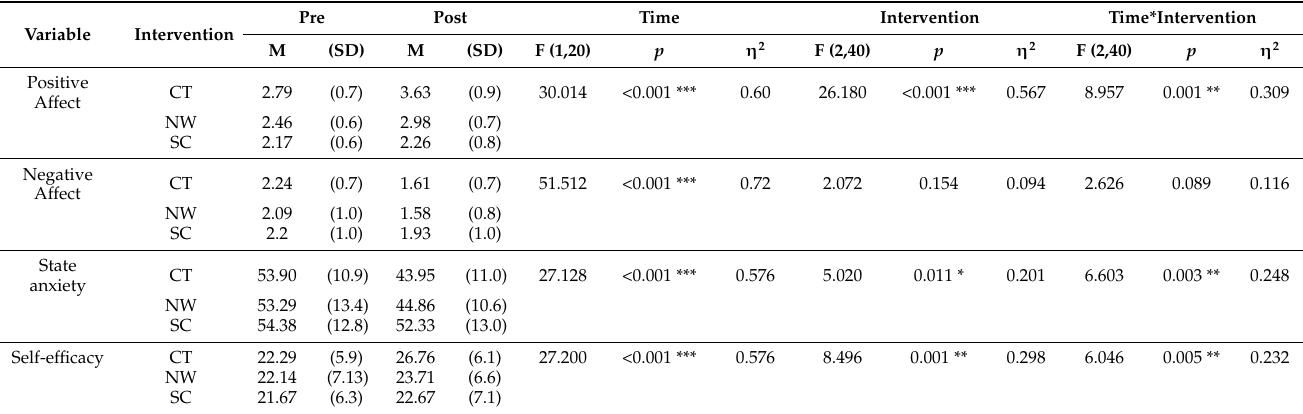
Table 1. Results of positive and negative affect, state anxiety and self-efficacy for the three interven- tions,